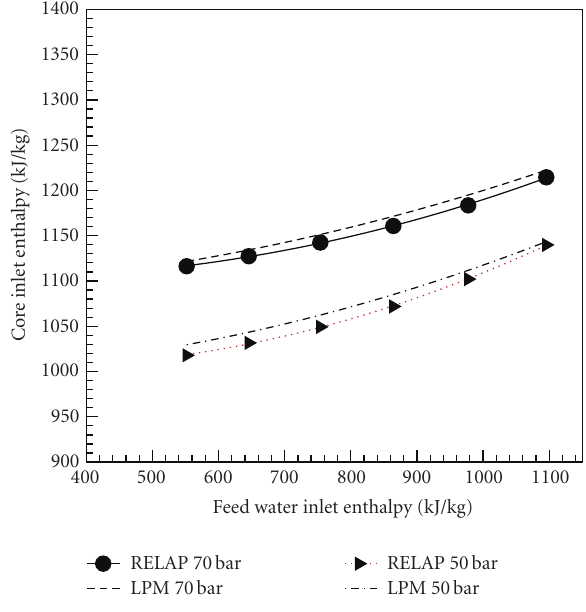
Figure 7: Variation of CIE with